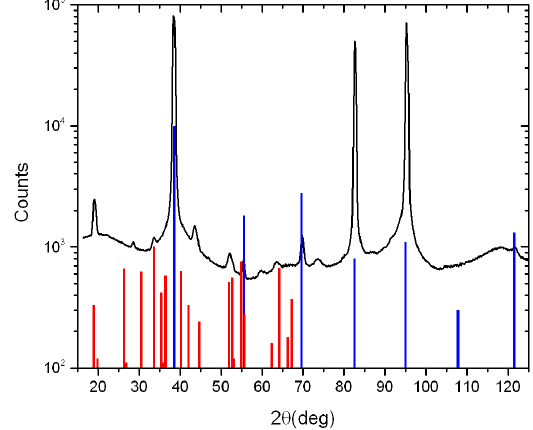
FIG. 22. XRD spectrum of sample L51. The vertical scale is expanded to show the presence of minor peaks. Vertical bars represent the relative intensities of tabulated powder diffraction spectra for bulk Nb (blue) and (cid:8) - Ti